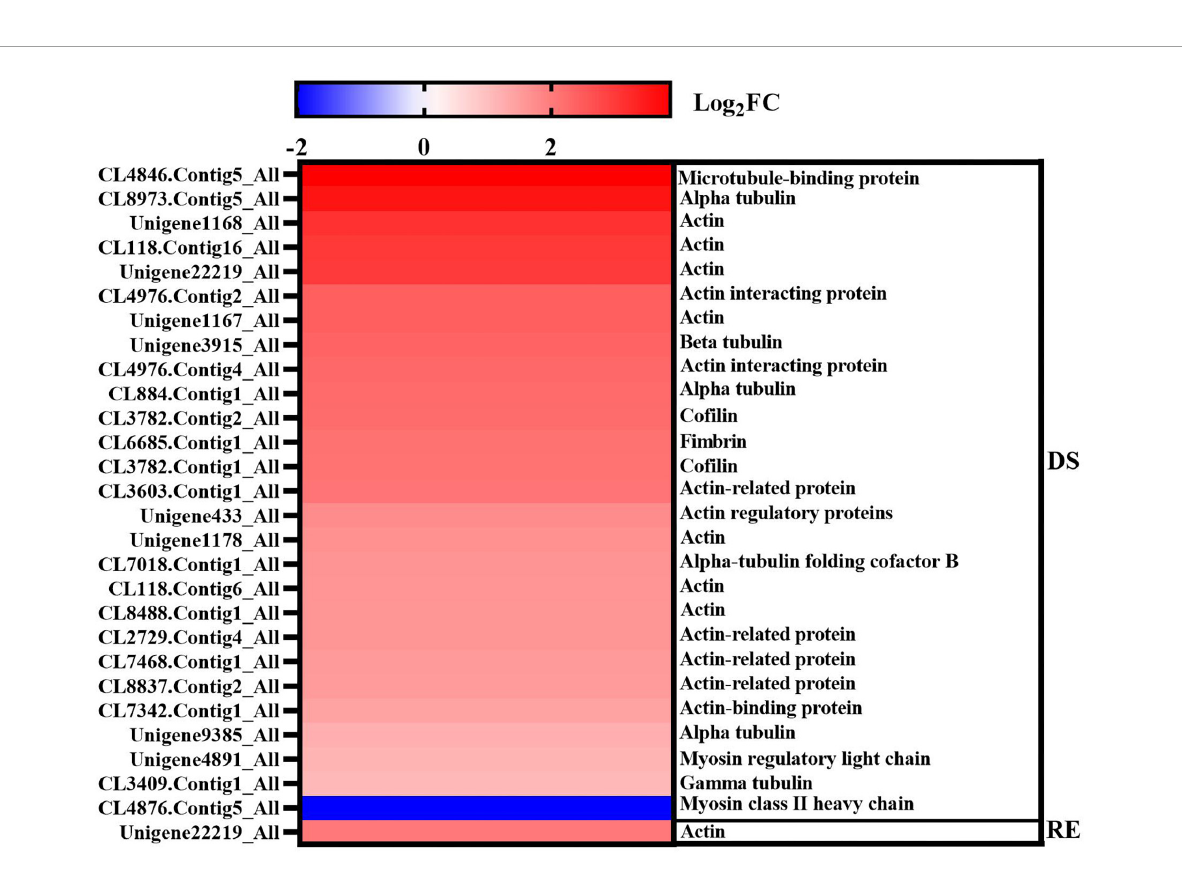
Frontiers in Plant